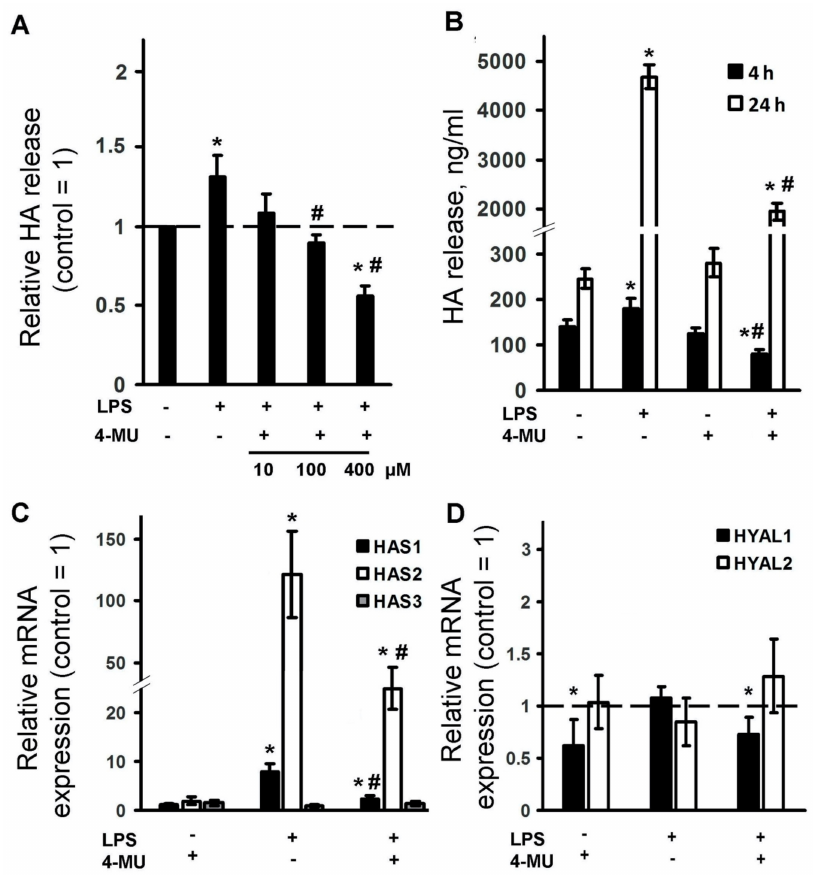
Figure 3. Modulation of LPS-induced hyaluronic acid (HA) release and mRNA expression levels of HA metabolizing enzymes, HA synthases (HAS1, HAS2, HAS3), hyaluronidases (HYAL1 and HYAL2) by 4-methylumbelliferone (4-MU). ( A ): the primary rat astrocyte cultures were pretreated with 4-MU, 10 µ M, 100 µ M or 400 µ M) for 30 min and then stimulated with lipopolysaccharide (LPS, 100 ng / mL) for 4 h. The HA release is measured by ELISA in supernatant samples. The results are expressed as fold-changes, relative to untreated cells. ( B – D ): astrocytes were pretreated with 4-MU, 400 µ M for 30 min and then stimulated with LPS (100 ng / mL) for 4 h ( B – D ) or 24 h ( B ). ( B ): the HA release was measured by ELISA in supernatant samples. The results are expressed as ng / mL. ( C , D ): the mRNA levels of HAS1, HAS2, HAS3, HYAL1 and HYAL2 were determined by quantitative real-time PCR (qPCR). The values are normalized to β -actin mRNA levels. The results are expressed as fold-changes, relative to untreated cells. * p < 0.05, compared with the naive cells, # p < 0.05, compared with the LPS-stimulated